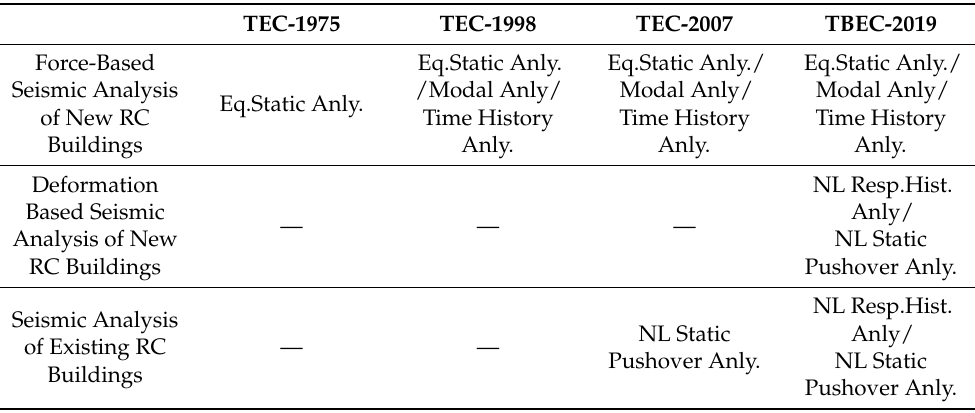
Figure 1. Earthquake codes and analysis methods. Table 1. Earthquake Code Analysis Methods.